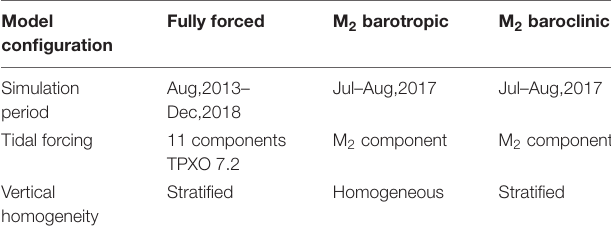
TABLE 1 | The configurations of the model simulations used in the